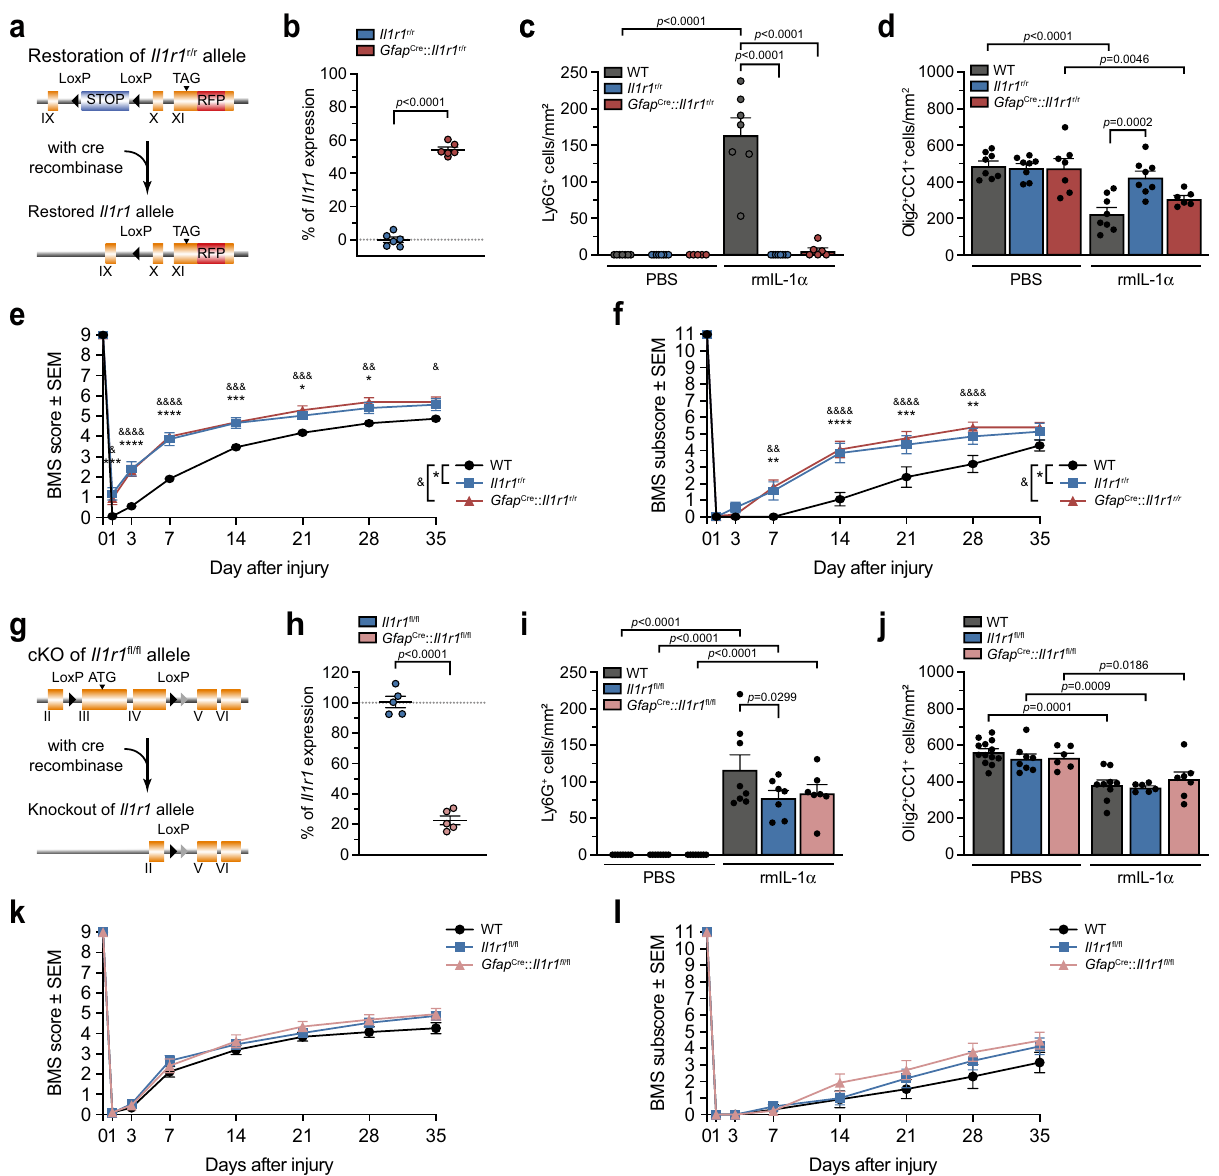
Fig. 8 | IL-1 α -induced neuroin fl ammation and oligodendrocyte loss is partly mediated by astrocytic IL-1R1. a Genetic design of the Gfap Cre :: Il1r1 r/r mouse line. b Quanti fi cation of Il1r1 gene expression in primary brain astrocytes from adult Il1r1 r/r miceexpressinganIL-1R1-knockoutphenotype(setto 0%)and Gfap Cre :: Il1r1 r/r mice ( n =6 mice/group). c Quanti fi cation of Ly6G + neutrophils that in fi ltrated the spinalcordof WT, Il1r1 r/r and Gfap Cre :: Il1r1 r/r miceat24h post-i.c.m. injectionofPBS or rmIL-1 α ( n =7 WT+PBS, n =8 Il1r1 r/r +PBS, n =5 Gfap Cre :: Il1r1 r/r +PBS, n =7 WT+ rmIL-1 α , n =8 Il1r1 r/r +rmIL-1 α , n =6 Gfap Cre :: Il1r1 r/r +rmIL-1 α ). d Quanti fi cation of Olig2 + CC1 + matureoligodendrocytesinthespinalcordat24hpost-injection( n =8 WT+PBS, n =8 Il1r1 r/r +PBS, n =7 Gfap Cre :: Il1r1 r/r +PBS, n =8 WT+rmIL-1 α , n =8 Il1r1 r/r +rmIL-1 α , n=6 Gfap Cre :: Il1r1 r/r +rmIL-1 α ). e , f Locomotor function was asses- sed usingtheBMSscore( e )and BMSsubscore( f )afterSCI( n =16WT, n =15 Il1r1 r/r , n =15 Gfap Cre :: Il1r1 r/r ). g Geneticdesignofthe Gfap Cre :: Il1r1 fl / fl mouseline. h Il1r1 gene